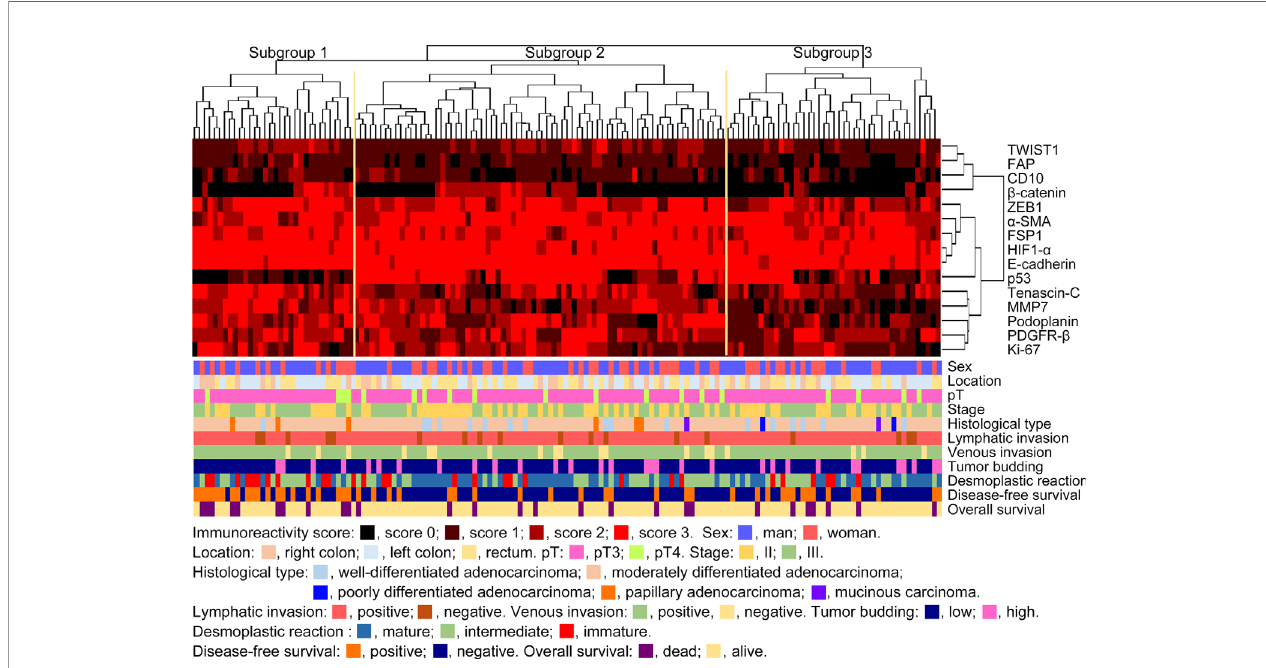
FIGURE 2 | Hierarchical cluster analysis of colorectal cancer patients with stage II or III disease based on the expression patterns of cancer cells and cancer- associated fi broblast (CAF) proteins in the fi rst cohort. The examined CRCs were subclassi fi ed into 3 subgroups.